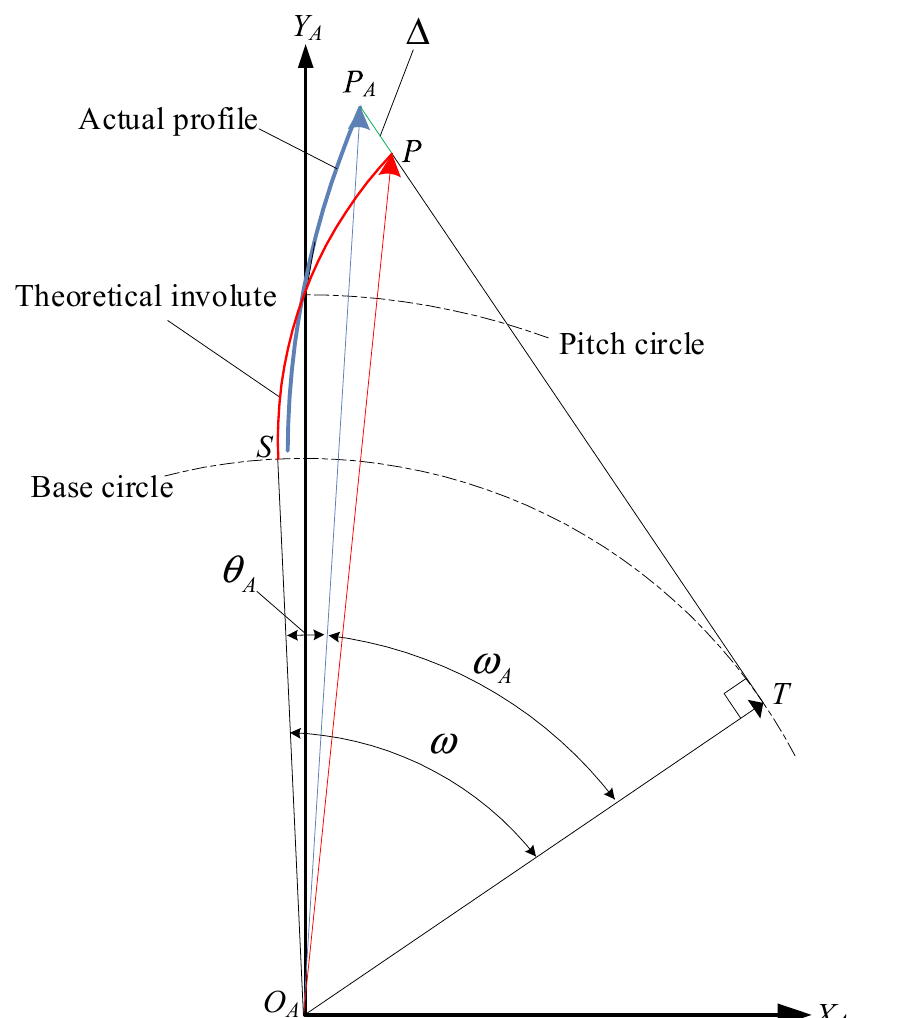
Figure 9. Determination of the profile error with respect to a theoretical involute.